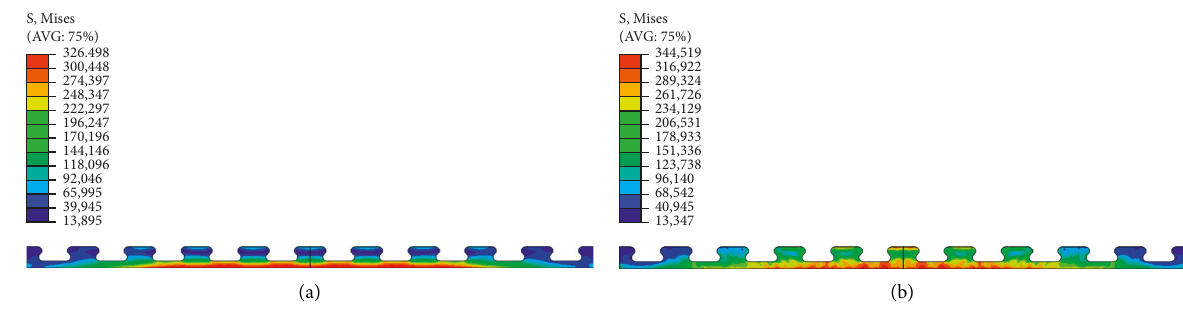
Figure 17: Stress of the PZ shear connectors. (a) Under 70% of the ultimate load. (b) Under the ultimate load. DAMAGEC (AVG: 75%)